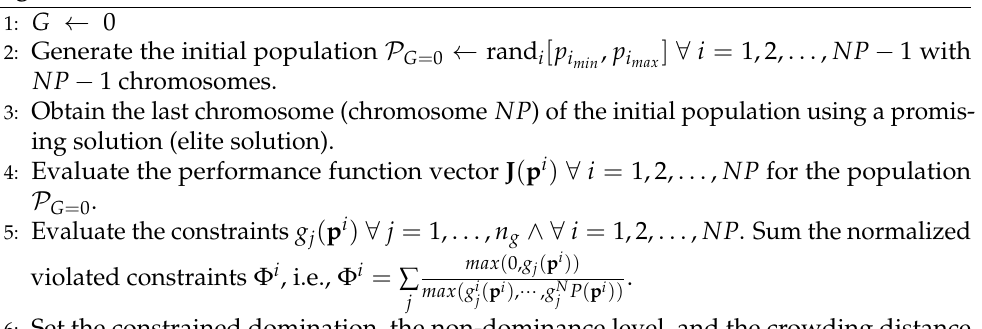
Algorithm 1 Pseudocode of the